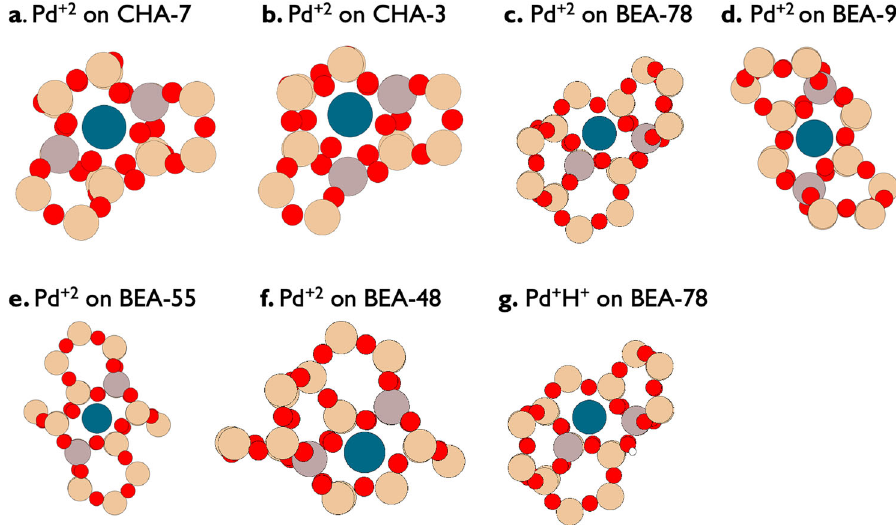
Fig. 5 QM atoms from selected QM/MM structure optimizations. Color coding: red = oxygen, gray = aluminum, blue = palladium, and beige = silicon. NATURE COMMUNICATIONS| (2022) 13:2910